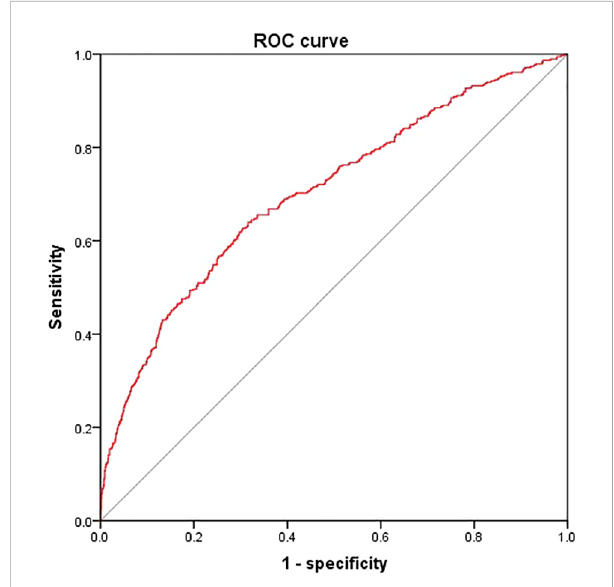
FIGURE 3 Receiver operating characteristics curves of DKD risk score. We put HGI, age, T2DM duration, SBP, TC, FCP and eGFR into the model The area below the ROC curve of this model was 0.702 (95% CI : 0.671 - 0.734). The sensitivity and speci fi city corresponding to the maximum Youden index were 0.640% and 0.649%